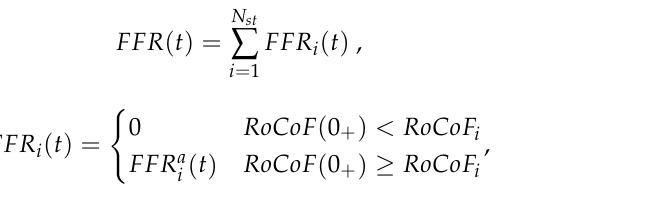
Figure 8. Representation of the transmission network divided into coherency areas.